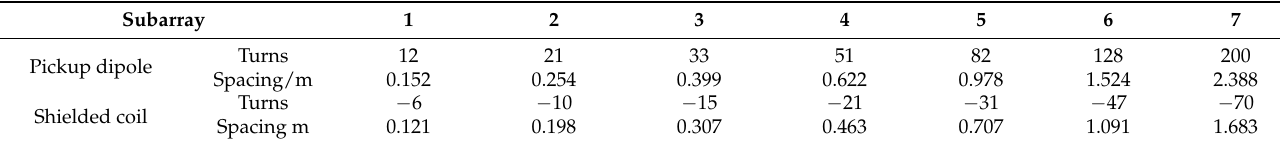
Figure 2. Structure diagram of HDIL detection tool. Table 1. Subarray parameters for HDIL detection tool.